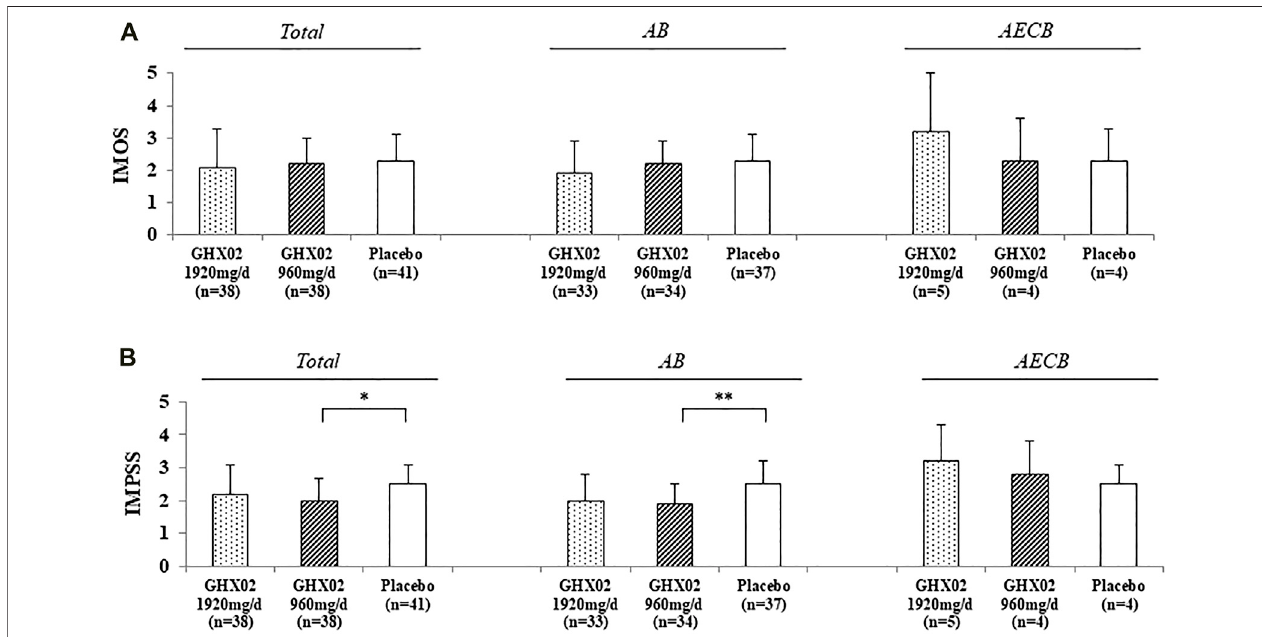
FIGURE 5 | Integrative Medicine Outcome Scale (IMOS) and Integrative Medicine Patient Satisfaction Scale (IMPSS) in Day 7. (A) IMOS (B) IMPSS. Results are expressed asmean ± SD with 95%con fi dence intervals (CIs) in FAS analysis. p -valuesindicate signi fi cance ofmean differences inthe valuebetweengroups (* p < 0.05, ** p < 0.01, and *** p < 0.001). AB, Acute Bronchitis; AECB, Acute Exacerbations of Chronic